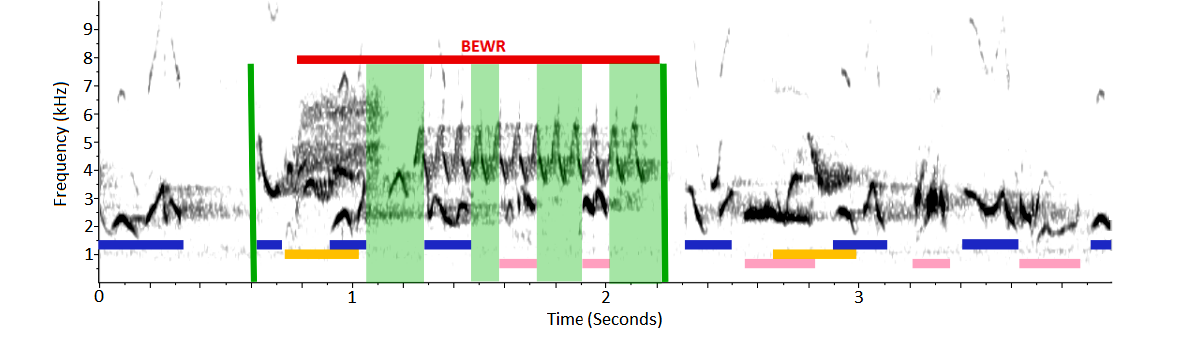
Fig. 6 . Spectrogram representation of a short period of song during the experiment with four sound sources. BHGR is highlighted in blue, CAVI in yellow, CATH in pink, and BEWR in red. When sounds were segmented coarsely, i.e., the area bounded by the two vertical opaque green lines, short bursts of BHGR song often overlapped the much longer BEWR song, leading to masking of the BEWR song. This effect could be minimized, and the BEWR sounds analyzed, by selecting nonoverlapped portions of BEWR song for analysis (transparent green boxes). The results of this approach are shown in Figure 7.